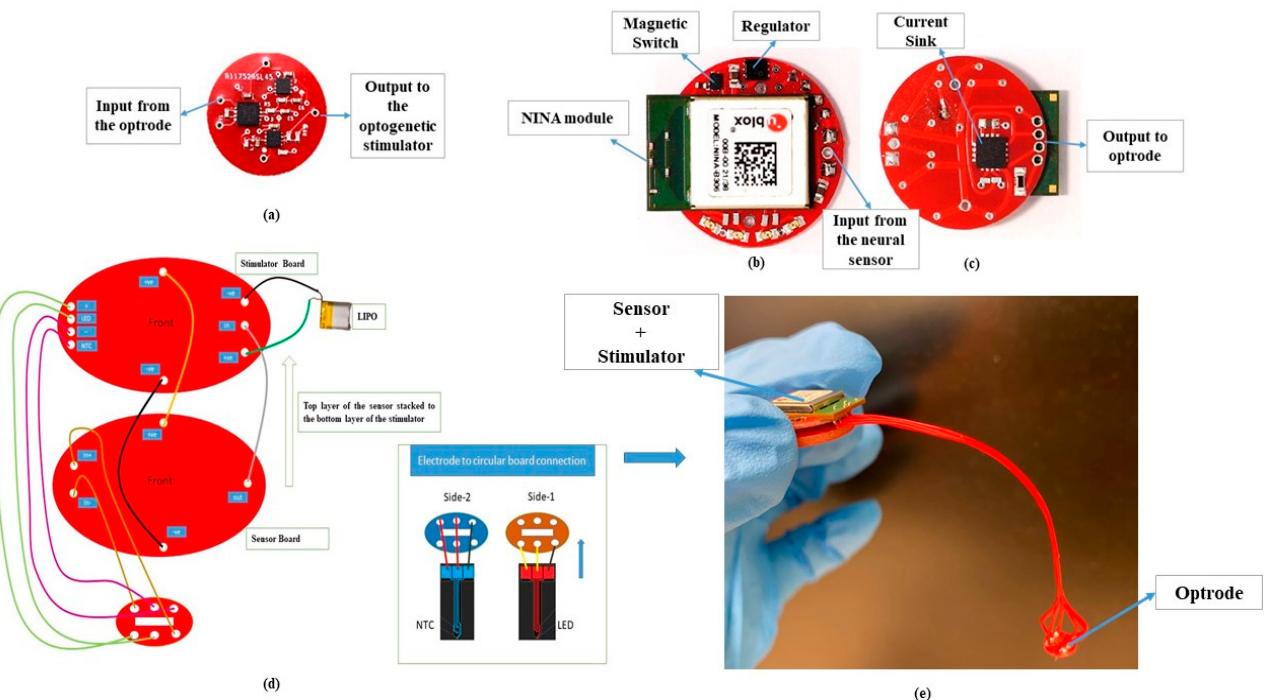
Figure 6. Physical design of: ( a ) neural sensor board, ( b ) optogenetic stimulator—front, ( c ) optoge- netic stimulator—back, ( d ) device design, and ( e ) final device design.